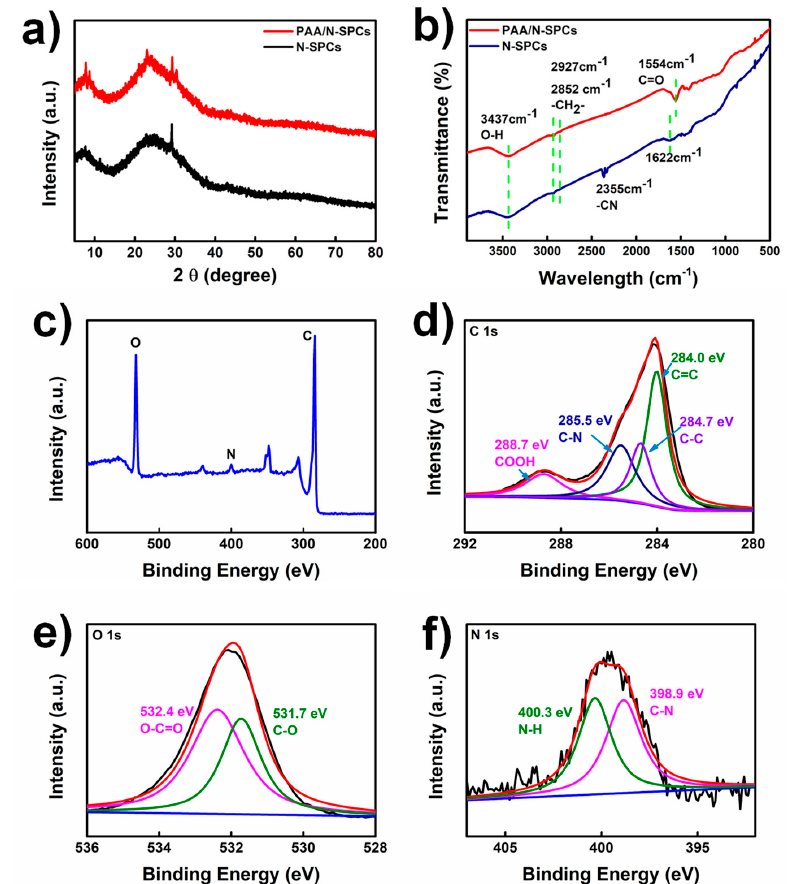
Figure 2. XRD patterns ( a ), FTIR spectra ( b ) of N-SPCs ( a ) and PAA/N-SPCs, XPS survey spectrum ( c ), and high resolution XPS spectra of C 1s ( d ), O 1s ( e ), and N 1s ( f ) for PAA/N-SPCs. In general, high surface area and porosity are conducive to provide more active adsorption sites for analytes. Therefore, the specific surface areas and pore size distributions of both N-SPCs and PAA/N-SPCs were evaluated using N 2 adsorption–desorption and BJH isotherms. As displayed in Figure 3a, the specific surface areas of N-SPCs and PAA/N-SPCs were calculated to be 517.7 and 485.7 m 2 /g, respectively. The average pore diameters of both N-SPCs and PAA/N-SPCs (Figure 3b) were observed with values of 3.6 and 405.2 nm, respectively, which confirmed the formation of both meso- and macro-porous structures. The mesopore and macropore volumes were obtained with values of 0.15 and 0.63 cm 3 /g for N-SPCs, and 0.13 and 0.58 cm 3 /g for PAA/N-SPCs, respectively. Plentiful porosity provided numerous channels for analytes transferring from the outer surface to inside. Although the specific surface area of PAA/N-SPCs was slightly lower than that of N-SPCs, the formed abundant chemical groups on PAA/N-SPCs, which was verified in FTIR and XPS analysis, improved the adsorption capacities for VHCs by polar interaction. Moreover, the thermal stability of as-prepared materials is essential as the desorption of SPME is performed in a GC–MS injector at 250 °C. Herein, the desorption of the as-prepared new SPME fiber in the GC–MS injector at 250 °C was carried out with scan mode (Figure S1). Results showed that no distinct interfering compounds were found, indicating the excellent thermal stability of the as-prepared SPME coating.